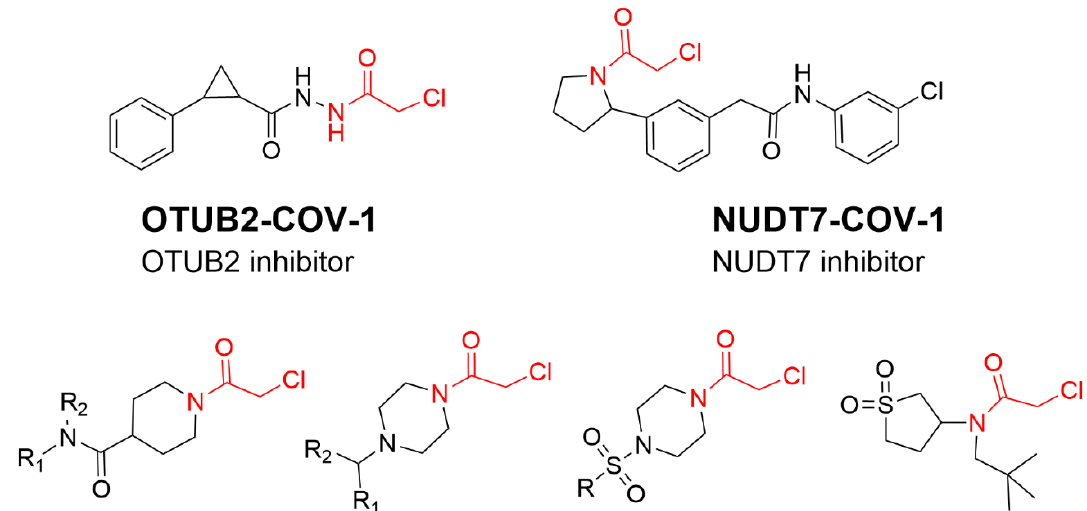
Figure 9. Chemical structure of representative chloroacetamide covalent fragment scaffolds targeting reactive cysteine.